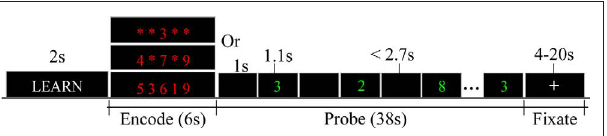
FIguRe 1 | The Sternberg item recognition paradigm (SIRP) fMRI task. A working memory fMRI task: During “ Encode ” a set of 1, 3, or 5 digits are presented and during “ Probe ” a series of single digits are presented. Subjects are asked to remember the “ Encode ” digits and identify them during “